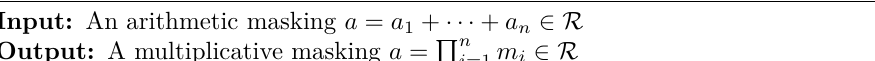
Algorithm 11 Additive to multiplicative conversion ( A2M